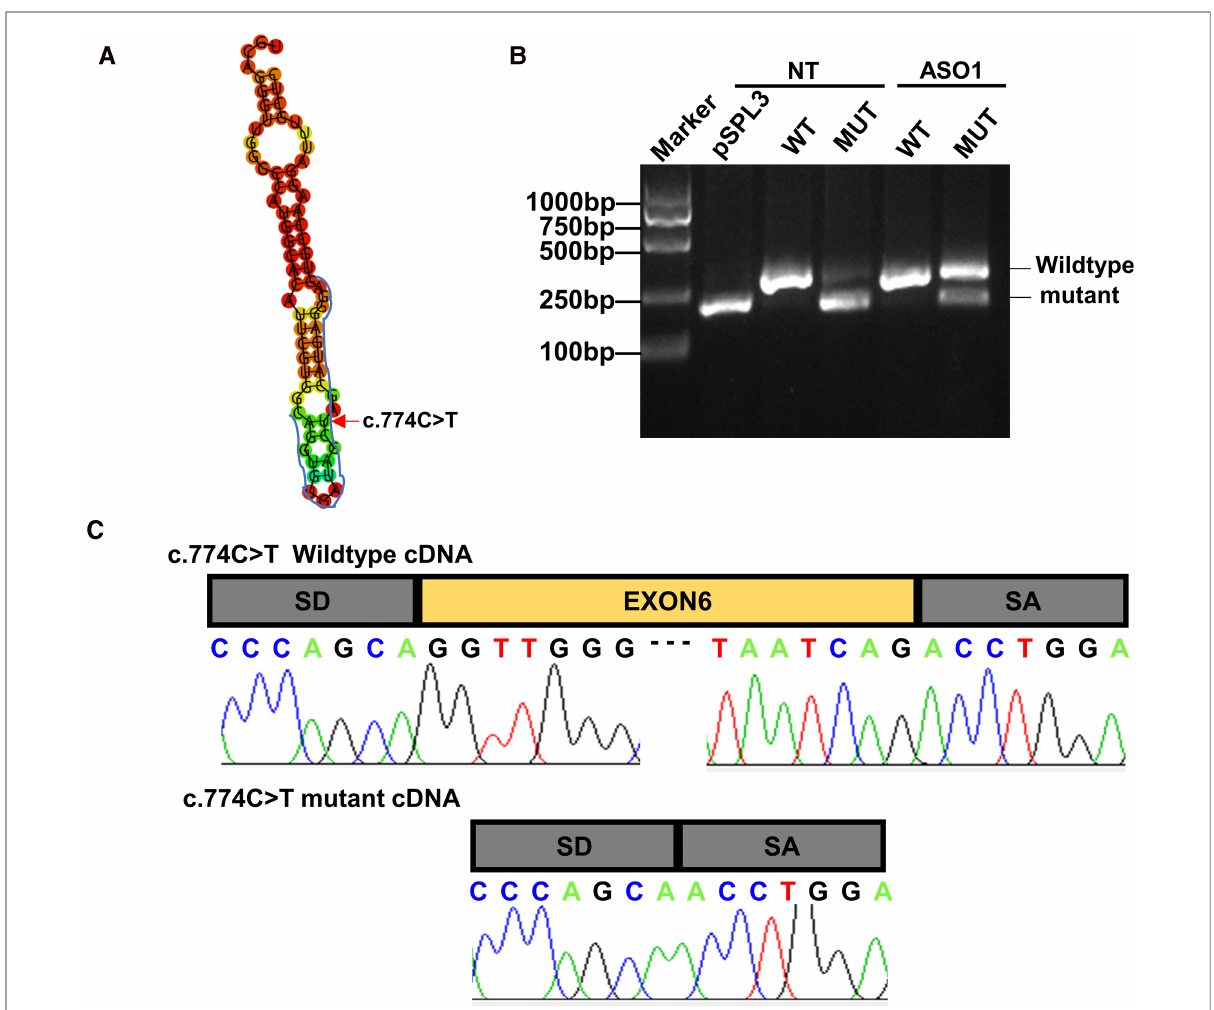
FIGURE 3 Antisense oligonucleotide partially rescue the exon skipping caused by c.774C>T variant in the MBTPS1 gene in HEK293 cells. ( A ) Positions of the antisense oligonucleotides (ASO) for the c.774C>T variant in this study. ( B,C ) Analysis of splicing correction by RT-PCR upon ASO. Wild-type(WT) minigene and the corresponding mutant(MUT) minigene containing the variant c.774C>T were transfected in HEK293. The ASO were then delivered except the non-treated lanes(NT). The exon skipping caused by c.774C>T was ef fi ciently rescued by